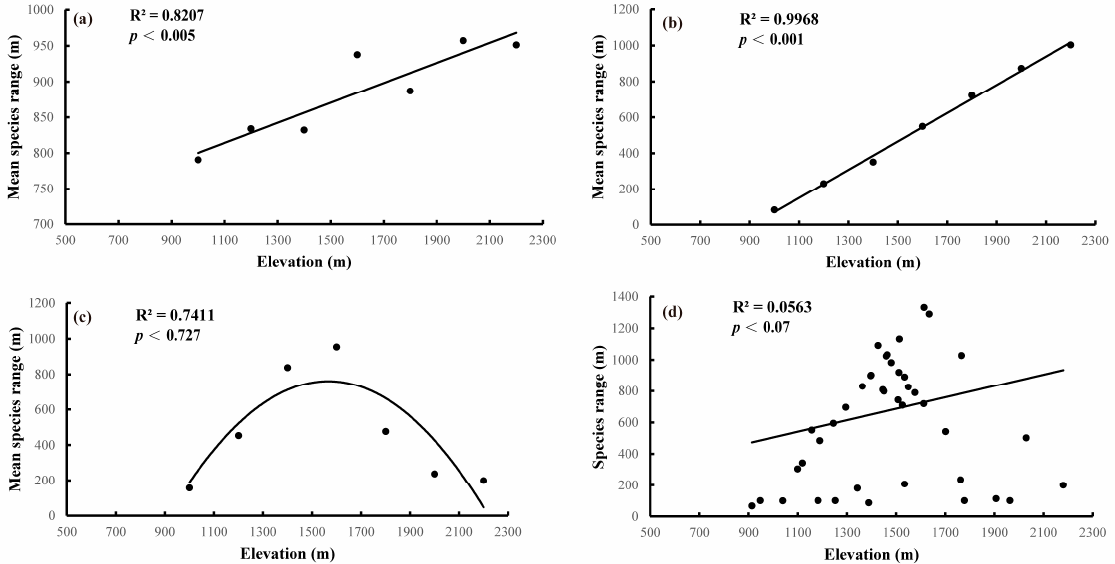
Figure 4. Results of four methods to test Rapoport’s effect. ( a ) Stevens’ method, ( b ) Pagel’s method, ( c ) Mid-point method, and ( d ) cross-species method.